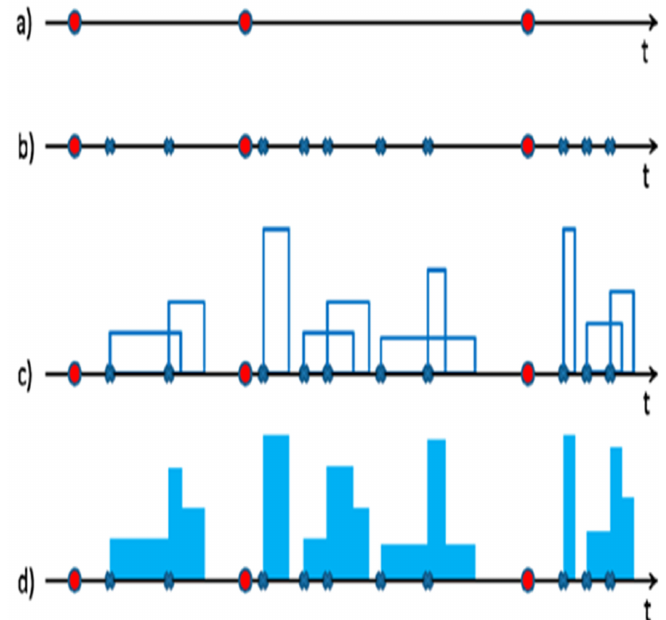
Figure 3. Representation of the (NSRP) stochastic process for at-site rainfall modeling (from [43]): ( a ) occurrences of storms; ( b ) for each storm, determination of the number of pulses and their temporal occurrences; ( c ) estimation of intensity and duration for all the pulses; ( d ) calculus of total intensity at time t. The model has a set of parameters that are usually calibrated by minimizing an objective function, which is defined as the sum of residuals between the considered statistical properties of the observed data at chosen resolutions and their theoretical expressions. The statistical properties are typically referred to as a high-resolution continuous time series. However, continuous high-resolution data sets are very short or absent in many locations, with respect to Annual Maximum Rainfall (AMR) with different durations that usually are available with an adequate sample size. For this reason, the possibility to calibrate the model using only AMR data [43–45] and basic statistics, such as cumulate values for monthly or annual rainfall, has been adopted here. Such choice allows for a better reconstruction of extreme events, which are of main interest in many hydrological studies, for instance in the case of soil erosion caused by intense rainfall events.